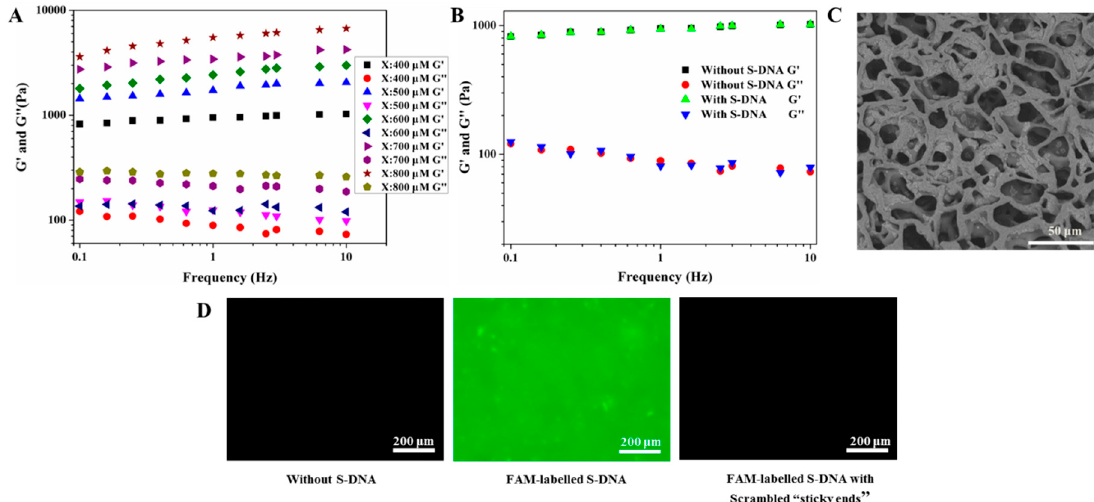
Figure 2. ( A ) The rheological property of DNA hydrogels with different concentrations (400 µ M, 500 µ M, 600 µ M, 700 µ M, and 800 µ M for X-DNA, the molar ratio of X-DNA and L-DNA is fixed at 1:2). ( B ) The storage and loss modulus of DNA hydrogel (X: 400 µ M and L: 800 µ M) with S-DNA or without S-DNA. ( C ) The SEM image of DNA hydrogel after freeze-drying (X: 400 µ M and L: 800 µ M). ( D ) Fluorescent images of hydrogels (X: 400 µ M and L: 800 µ M) without S-DNA, with carboxyfluorescein (FAM)-labeled S-DNA, and with FAM-labeled S-DNA with scrambled “sticky ends”.